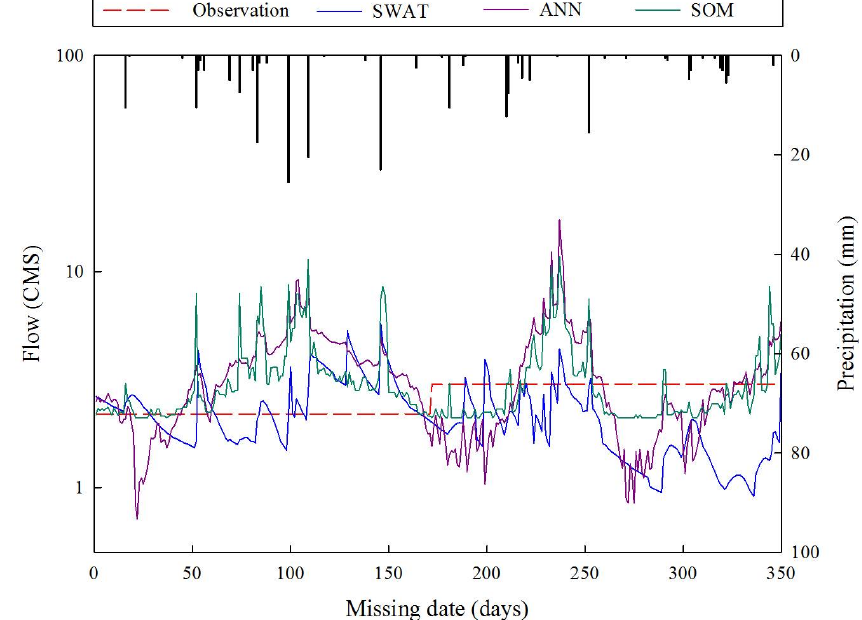
Figure 4. Data imputation results of 350 missing flow data for the SWAT, ANN, and SOM models. Four line graphs represent the observation (red), SWAT (blue), ANN (purple), and SOM (green), while the bar graph at the top is the daily precipitation amount of the missing flow data.